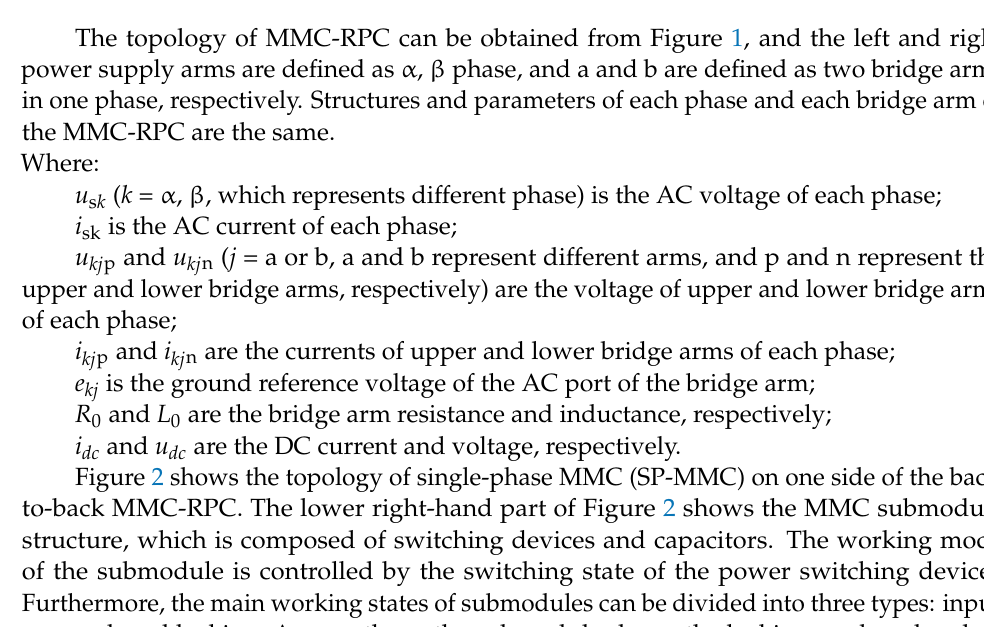
Figure 1. Topology of MMC-RPC.